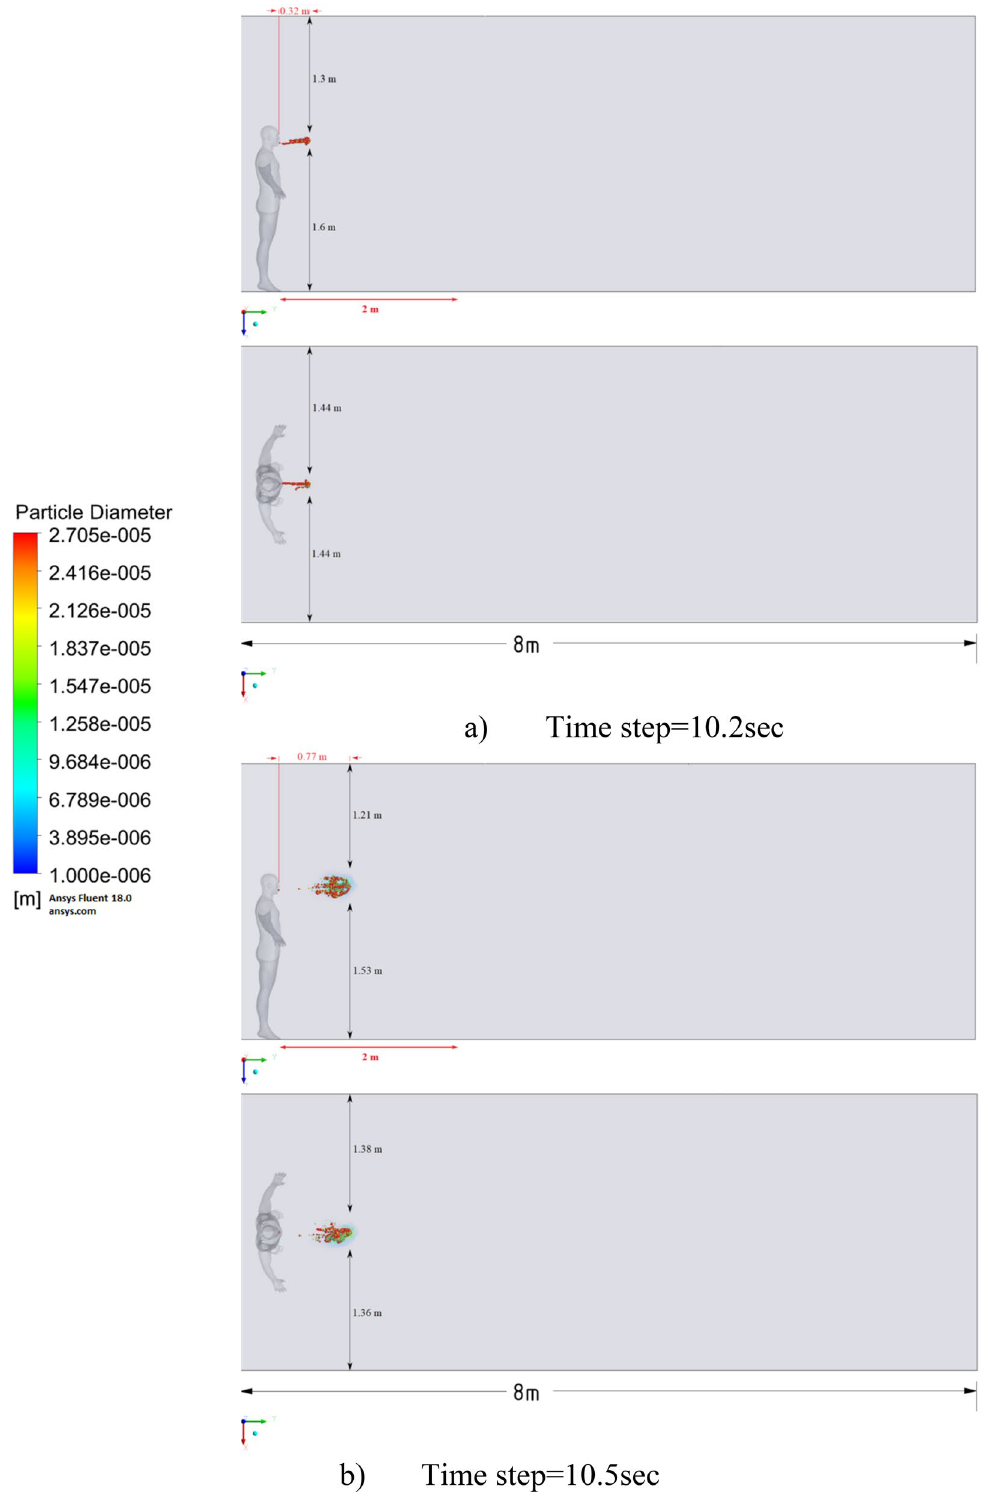
Figure 17. Distribution of the particles for cough = 20 m/s and ventilation = 0.5